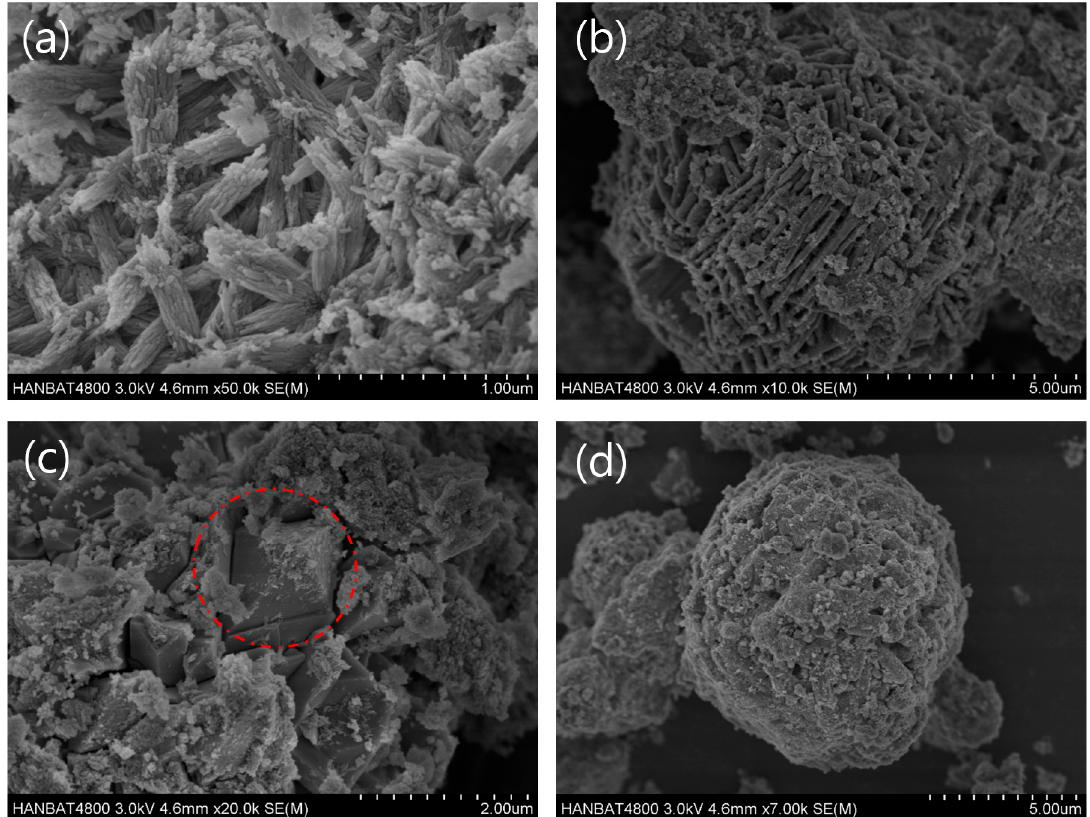
Figure 3. SEM images of ( a ) hydroxyapatite (obtained from HZ-5), ( b ) FAU zeolite (obtained from HZ-3), ( c ) Na-P1 zeolite (obtained from HZ-5), and ( d ) hydroxysodalite (obtained from HZ-5).